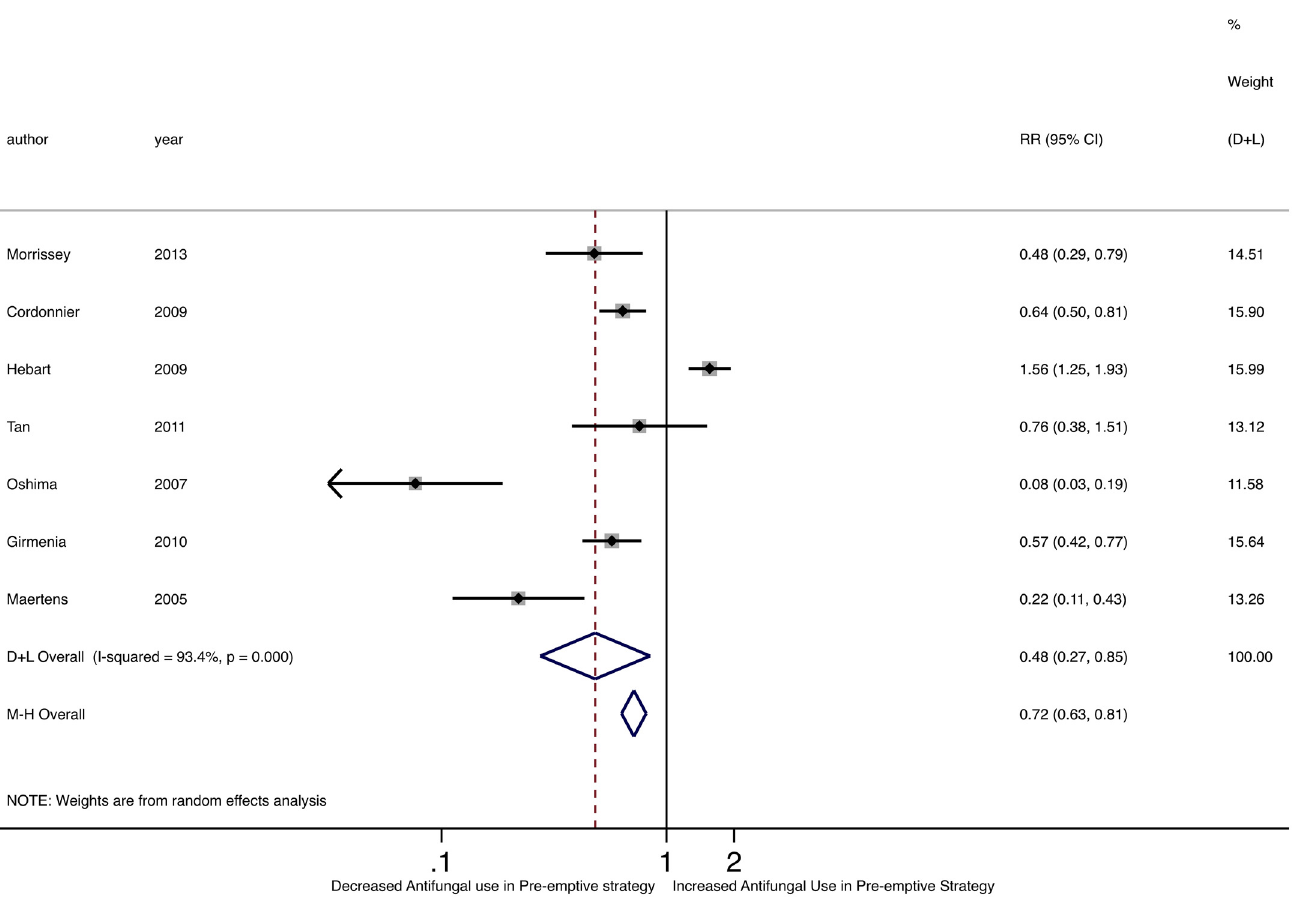
Fig 8. Forest plot of pooled relative risk of antifungal drug use comparing pre-emptive to empirical strategies.